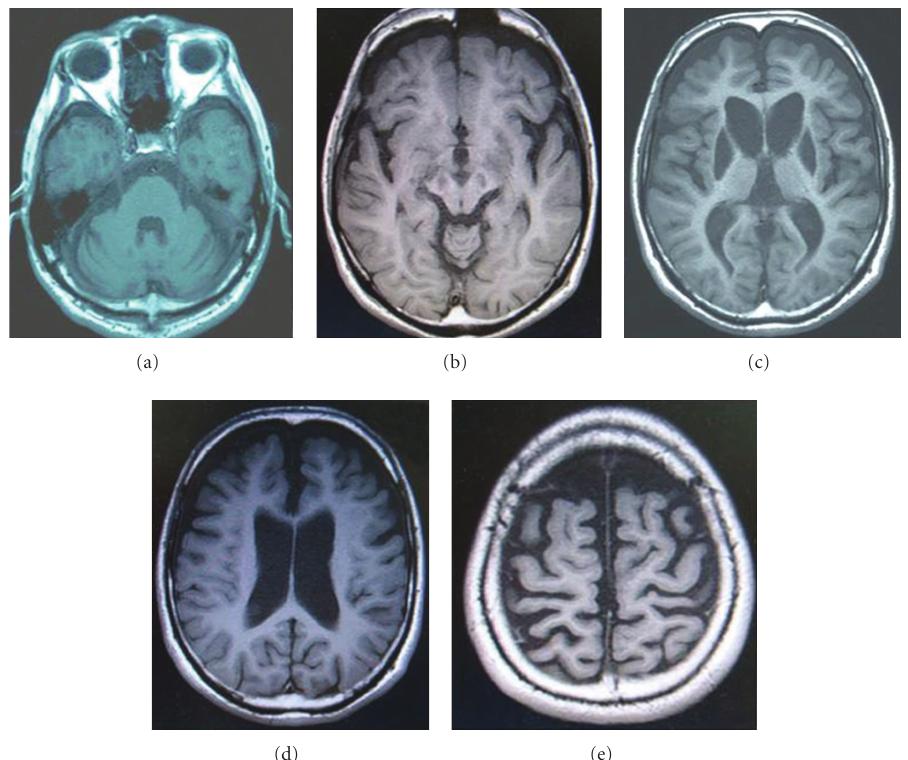
Figure 2: T1-weighted images (TR 400 msec/ TE 9msec) of the same patient at 42 years of age. (a) A cross-section at the pontine level shows cerebellar cortex atrophy. (b) An image of a midbrain section demonstrates the hypointense change in the substantia nigra. (c) An image at the level of the basal ganglia shows symmetrical hypointense signals in the head of the caudate nucleus and globus pallidus. As compared with the findings at 35 years, the hypointense signals in the pallidum extend to the putamen. The cystic changes of the lenticular nuclei can be clearly observed. The shape of the cyst is fan shaped and exactly fits the region of the lenticular nucleus. The cerebral cortex in the frontal lobes is atrophic. The hypointense lesion in the caudate head observed in the image at 35 years of age seems to be combined with the hypointense signal of the anterior horn of the lateral ventricle. (d) In this image, enlargement of the lateral ventricles is evident. (e) This image shows cerebral cortical